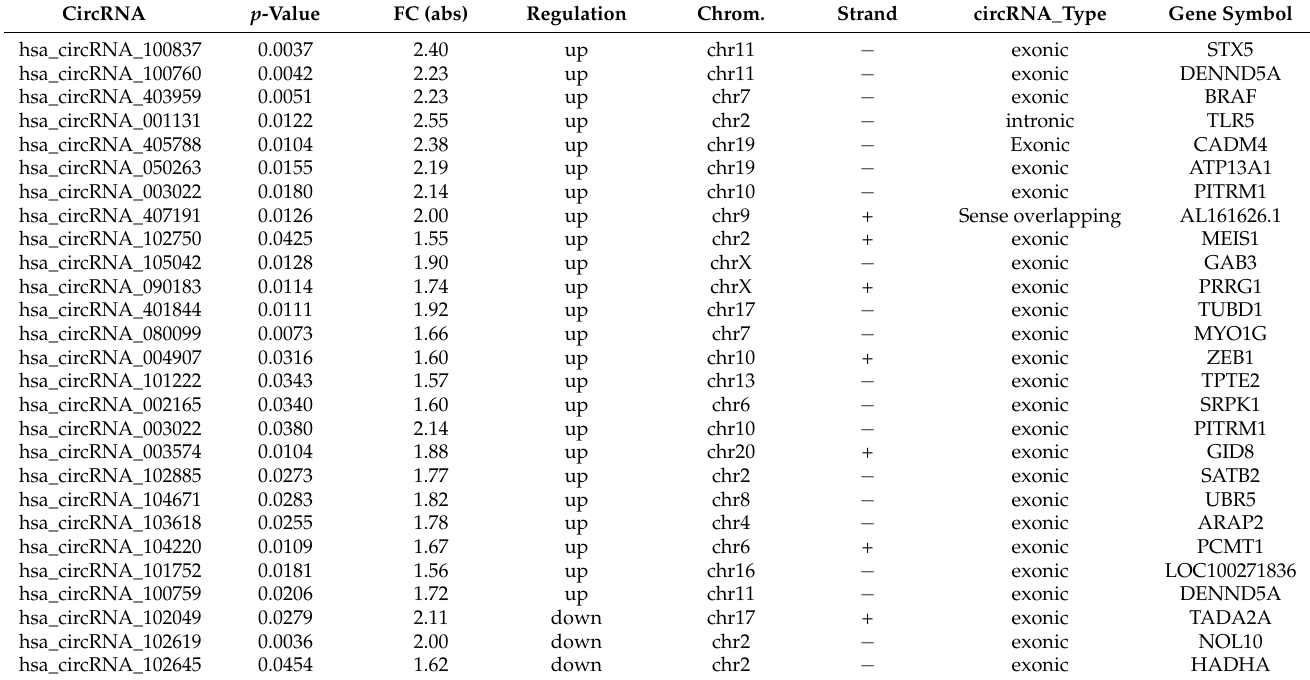
Table 2. Up and down regulated circRNAs in AD vs HC. Fold Change cut off: 2.0; p -value cut off: